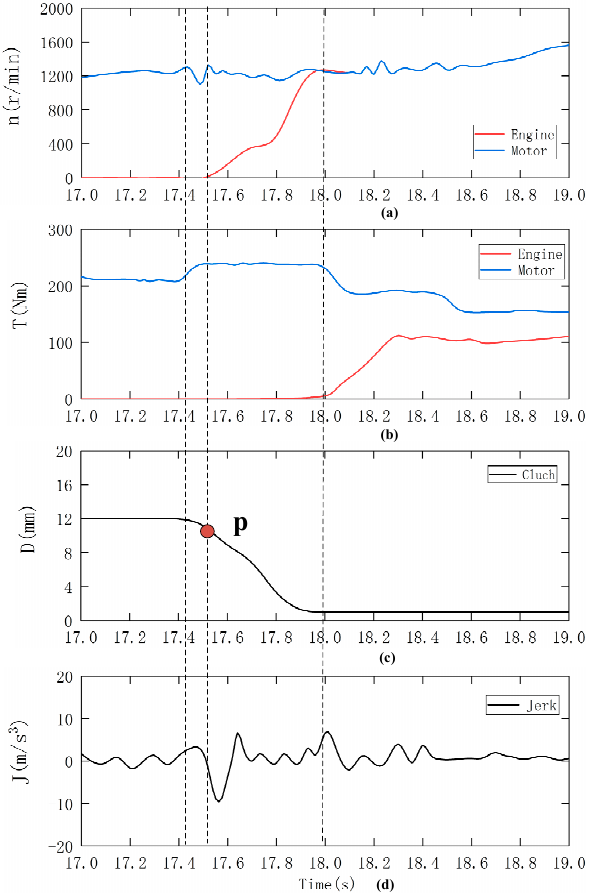
Figure 12. Results of the proposed method. ( a ) speeds of the engine and motor; ( b ) torques of the engine and motor; ( c ) displacement of the clutch ( d ) jerk of the driveline. Table 4. Experiment results comparison.